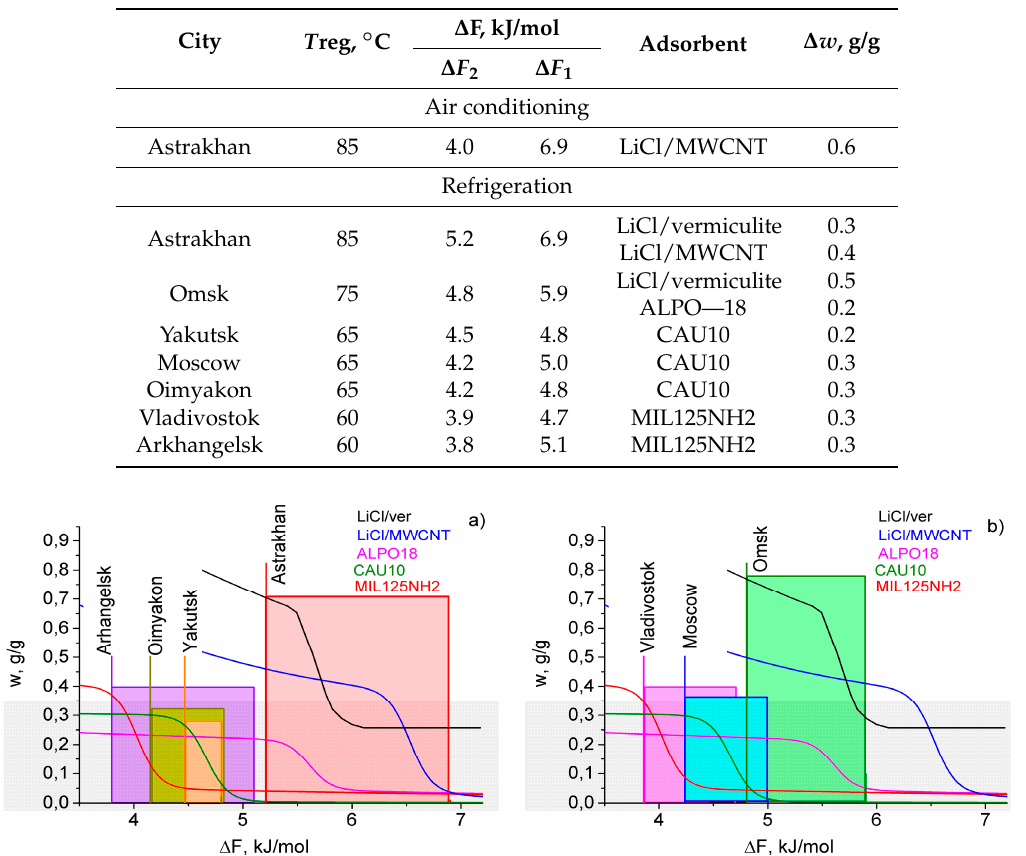
Table 1. The boundary conditions of cooling cycles analyzed and the amount of water exchanged under the discussed conditions for the adsorbents optimal for each zone. Figure 3. Average day ( a ) and night ( b ) temperatures for the climatic RF regions selected.